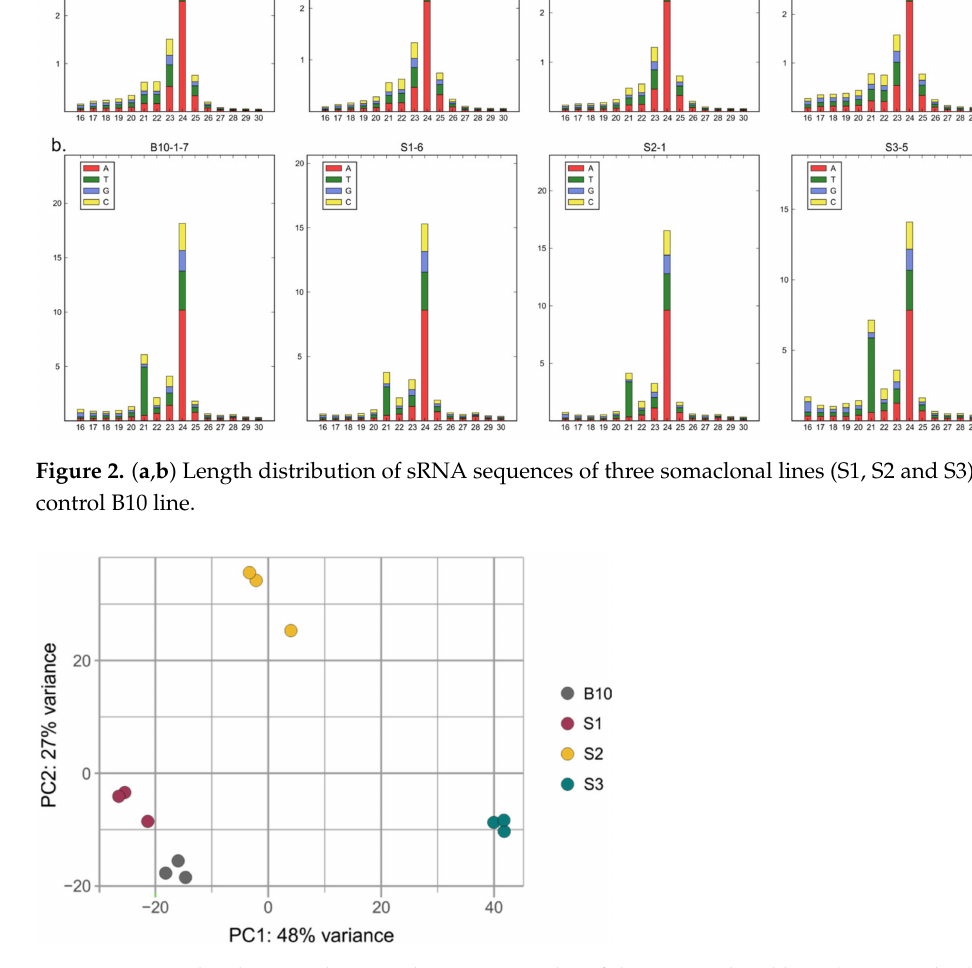
Figure 3. PCA plot showing distances between samples of three somaclonal lines (S1, S2 and S3) and control B10 line after